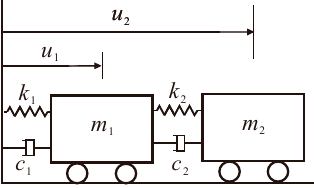
Figure 1. Two degrees-of-freedom system.